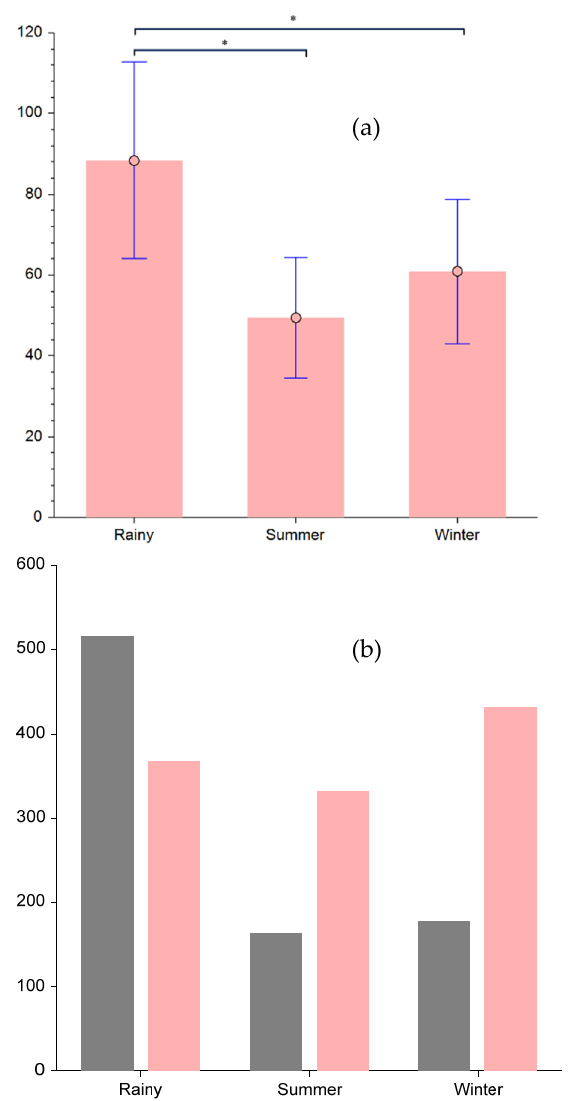
Figure 3. Bar graphs with error bars representing the number of endangered marine species across three seasons. ( a ) Comparison of mean and standard deviation of the number of stranded animals by season. Results of one-way analysis of variance (ANOVA) and Bonferroni test show a comparison of the number of stranded marine endangered species ( Y -axis) by season ( X -axis). Asterisks indicate that the rainy season was significantly different from summer and winter ( p < 0.05). ( b ) The bar graph presents the number of stranded animals ( Y -axis) by season and coastal location ( X -axis). The grey bars show the number of stranded animals in the Andaman Sea, while the pink bars show the number of stranded animals in the Gulf of Thailand. In addition, Pearson’s chi-squared test showed a significant association between coastal location and season ( p < 0.05).